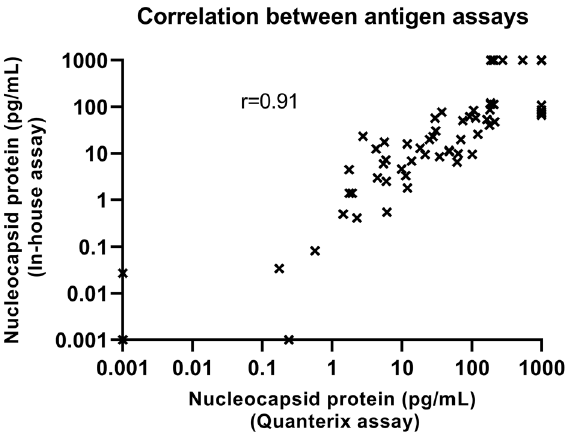
Figure 4. Correlation between the Quanterix assay and the in-house assay. The real time RT-PCR positive swab samples were used for the correlation. The r value calculated using Spearman’s ρ is shown.